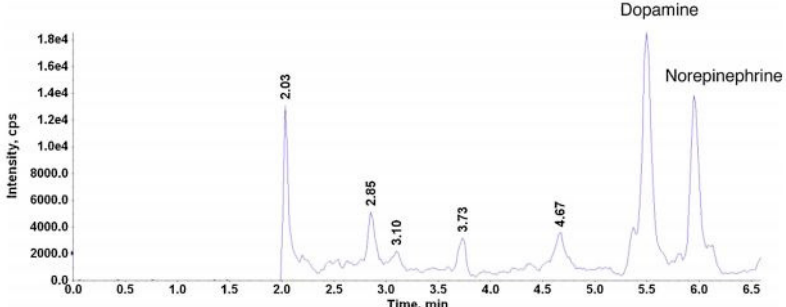
Figure 8. Chromatograms of dopamine and norepinephrine in a plasma sample. Figure adopted from reference [54] with the copyright permission.